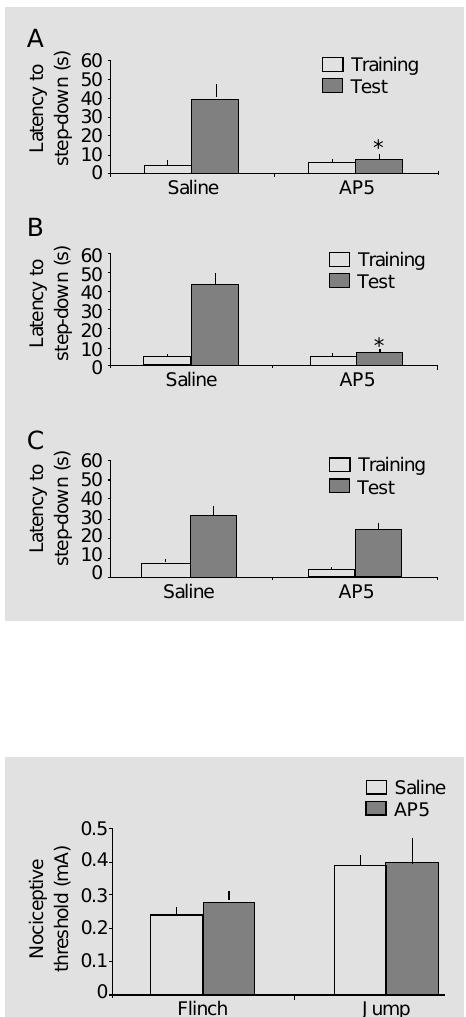
Figure 2 - Effects of pretraining (A), post-training (B), and pretest (C) infusions of D , L -2-amino-5- phosphonopentanoic acid (AP5) (5.0 µg) into the basolateral nucleus of the amygdala on re- tention of an inhibitory avoid- ance task. Data are means ± SEM of the step-down latencies; N = 8-11 animals per group. *P<0.01 compared to the ve- hicle group (unpaired t